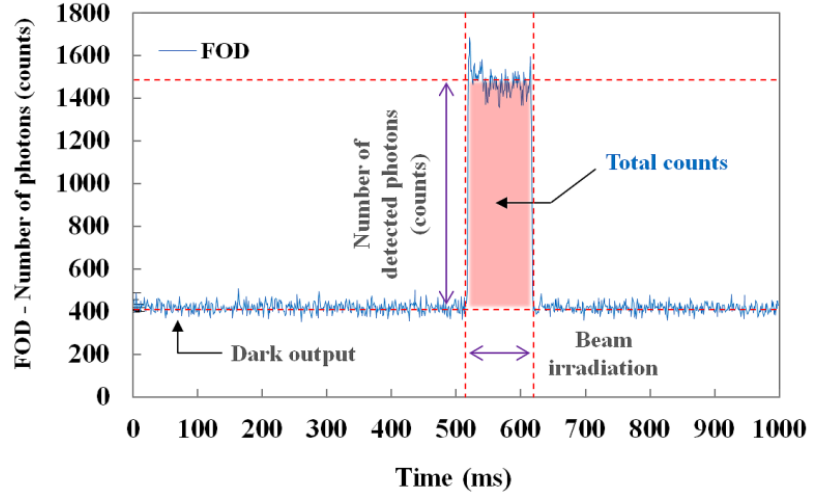
Figure 3. Raw data output from the MPPC module of the FOD